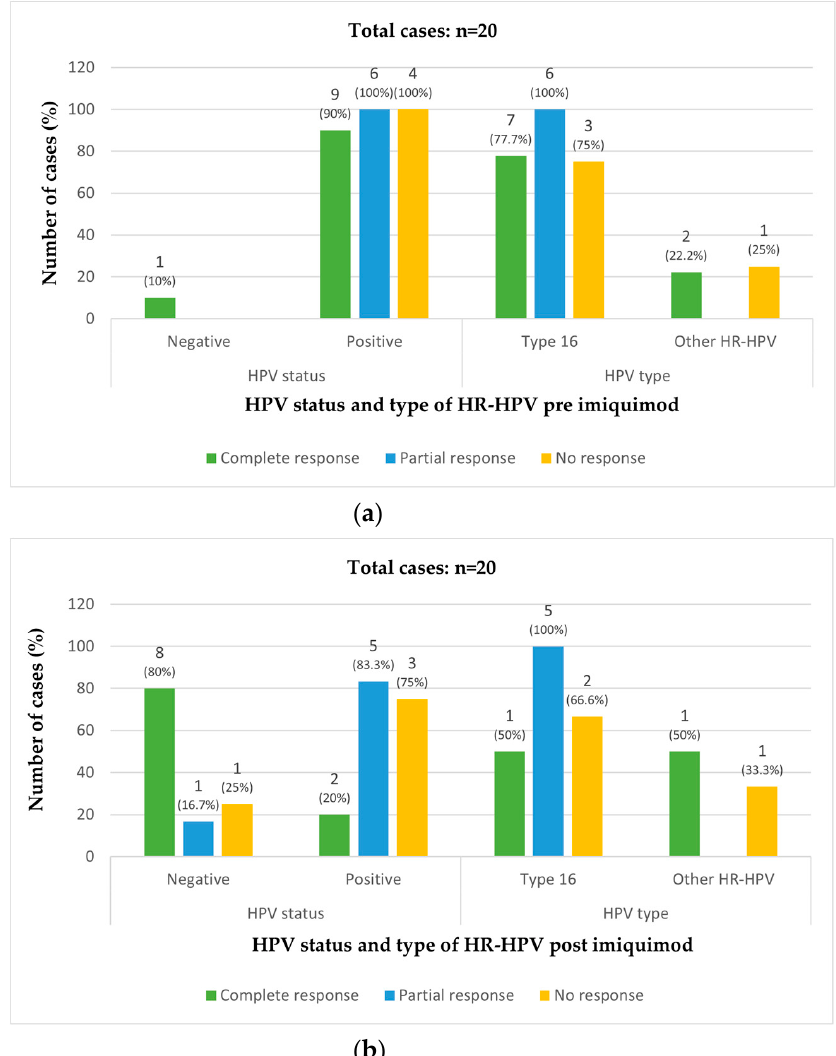
Figure 2. Number and percentage of cases of HPV and type of HR-HPV in the biopsies pre- and post-treatment with imiquimod in patients with complete, partial, and no response to treatment: ( a ) In HPV status, numbers in histogram and percentages are shown separately for each response. E.g., in complete response there are 10 cases where 1 (or 10%) and 9 (or 90%) correspond to negative and positive cases, respectively. In HPV type, numbers in histogram and percentages are obtained from positive HR-HPV cases inside each response separately (i.e., in complete response, there are 7 cases of type 16 or 77.7%, and 2 cases of other HR-HPV or 22.2% among the 9 positive HR-HPV cases). ( b ) In HPV status, numbers in histogram and percentages are shown separately for each response. In HPV type, numbers in histogram and percentages are obtained from positive HR-HPV cases inside each response separately. Ten cases received additional treatment following imiquimod treatment. Complete response: n = 10, Partial response: n = 6, No response: n = 4.